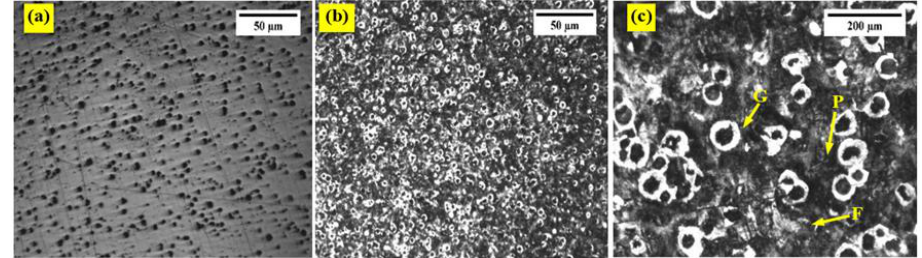
Figure 4: (a) Uniformity of graphite nodules before etched; (b) Graphite nodule growth uniformly after etched and microscopic magnification 50x, (c) Uniformity of graphite nodules with microscopic magnification 200x (G: graphite nodule, P: perlite and F: α